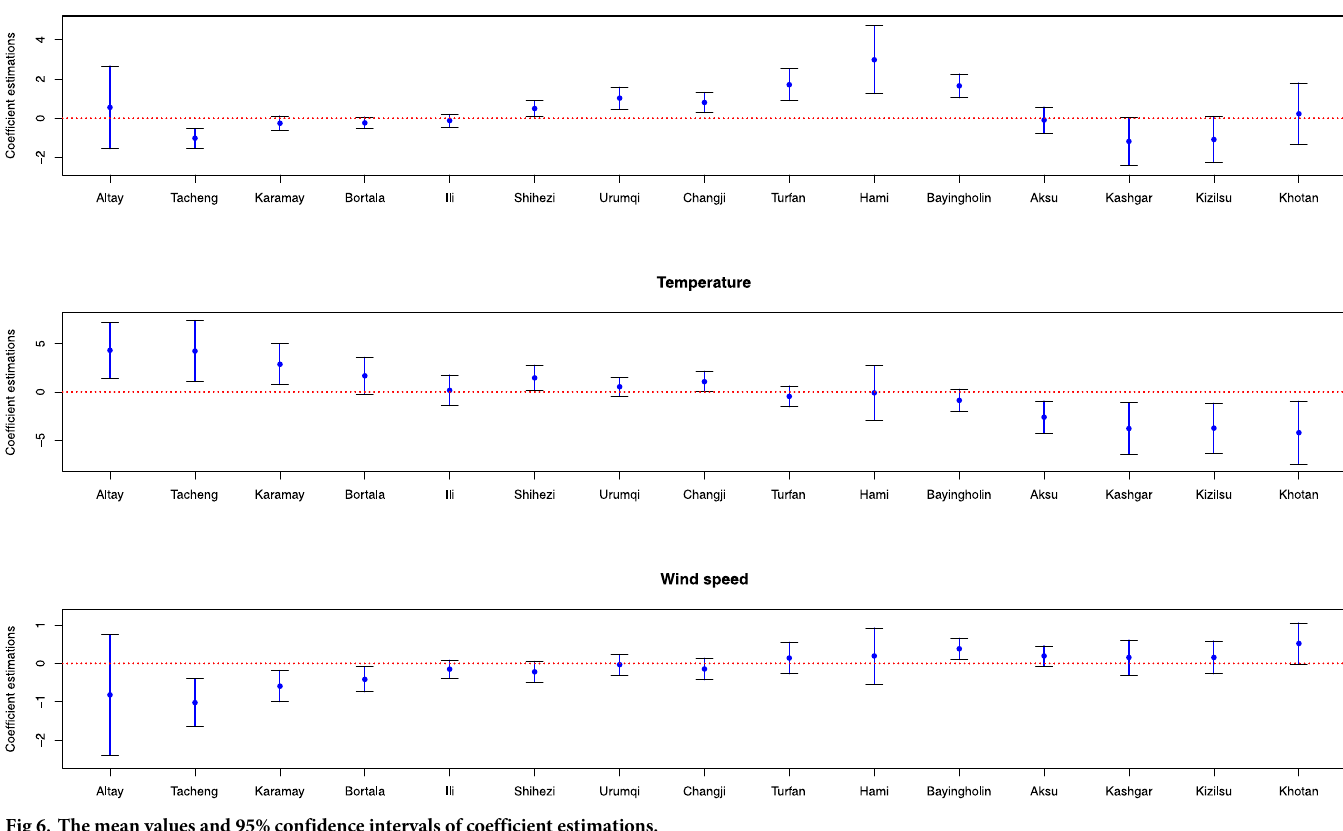
Fig 6. The mean values and 95% confidence intervals of coefficient estimations.